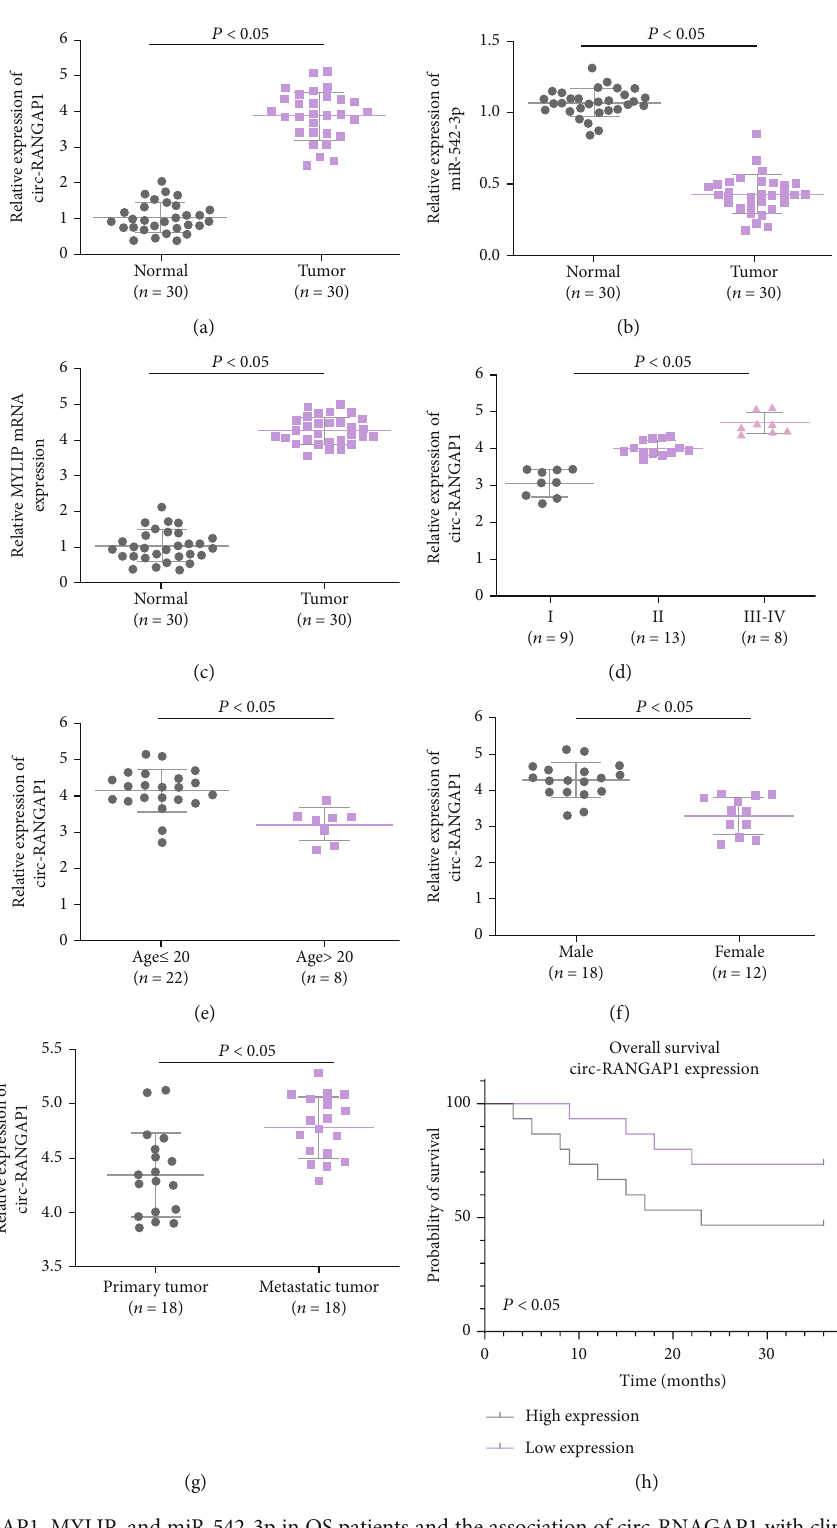
Figure 1: circ-RNAGAP1, MYLIP, and miR-542-3p in OS patients and the association of circ-RNAGAP1 with clinicopathological features and prognosis of patients. (a) circ-RANGAP1 in OS tissue and normal bone tissue. (b) miR-542-3p in OS tissue and normal bone tissue. (c) mRNA of MYLIP in the OS tissue and the normal human bone. (d) In fl uence of TNM staging on circ-RANGAP1. (e) Impact of age on circ- RANGAP1. (f) In fl uence of gender on circ-RANGAP1. (g) Impact of lymph node metastasis on circ-RANGAP1. The data in the fi gure were all measurement data in the form of mean ± SD . (h) Analysis of survival prognosis of OS patients was via